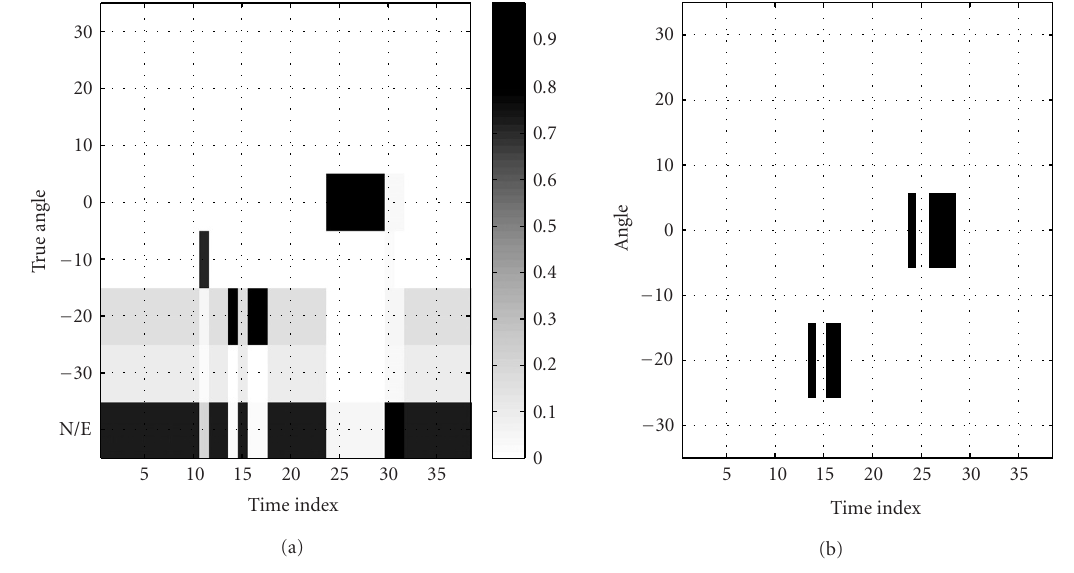
Figure 11: Detected and true speech events. (a) Inference results, (b) true speech